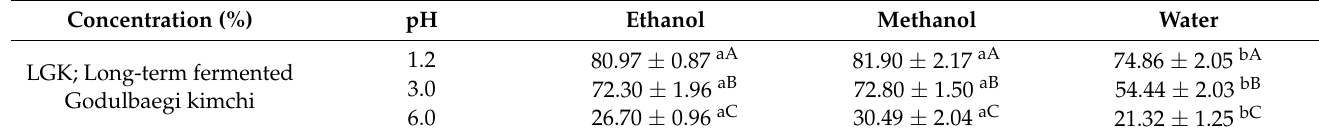
Table 3. The activity of nitrite scavenging (%) of Godulbaegi kimchi by fermentation duration using diverse